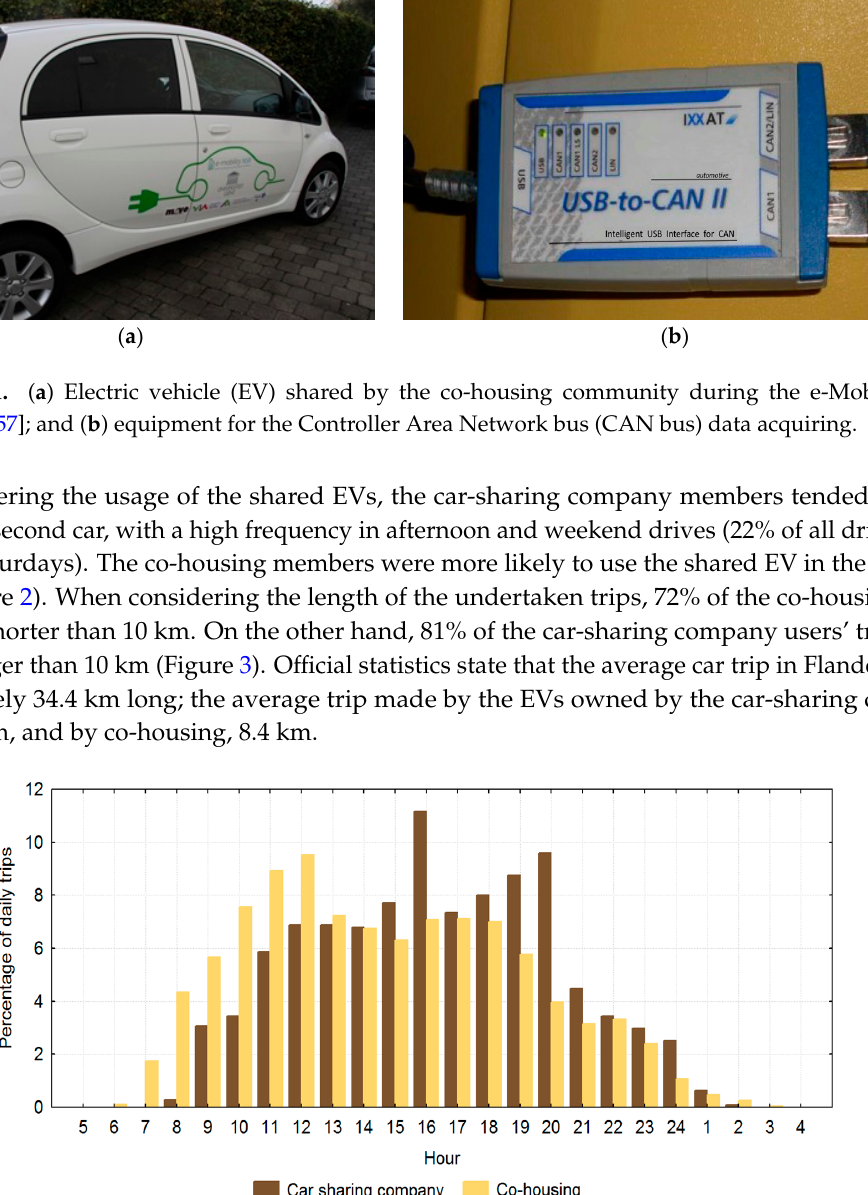
Figure 3. Driving behavior—distribution of trip lengths.